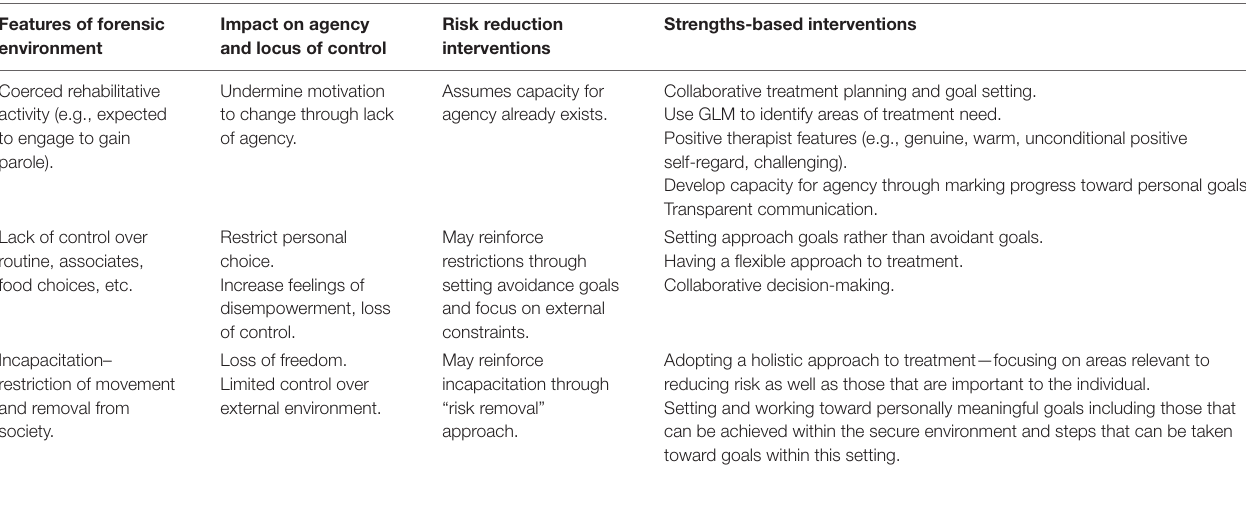
Features of forensic environment